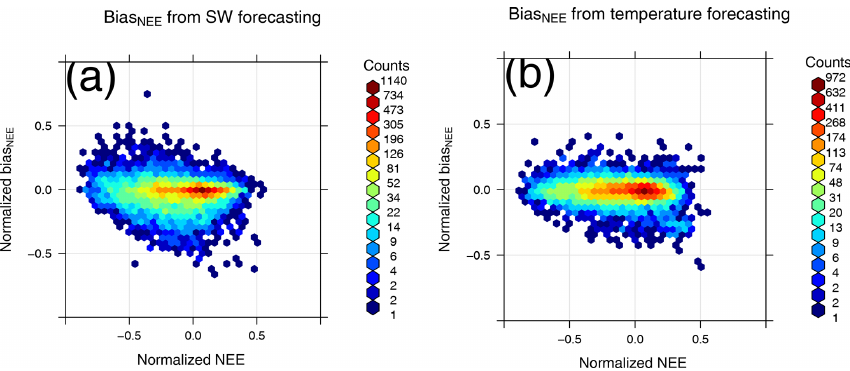
Figure 4. The Bias NEE distribution of experiment (b1) (a) and (b2) (b) . In experiment (b1) only SW is from 5d forecast, while other variables are the same with the reference simulation; in experiment (b2), it is air temperature that only comes from 5d forecast. The MAEs to the reference experiment are 0.053 and 0.042,